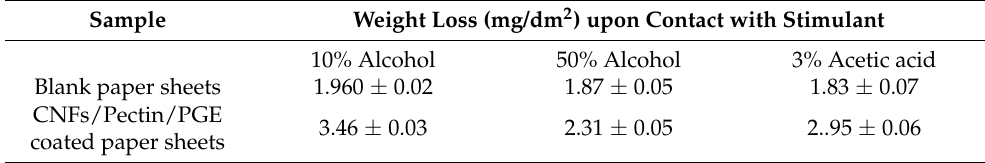
Table 10. Overall migration test results of CNFs/20% Pectin/PGE coated paper sheets.